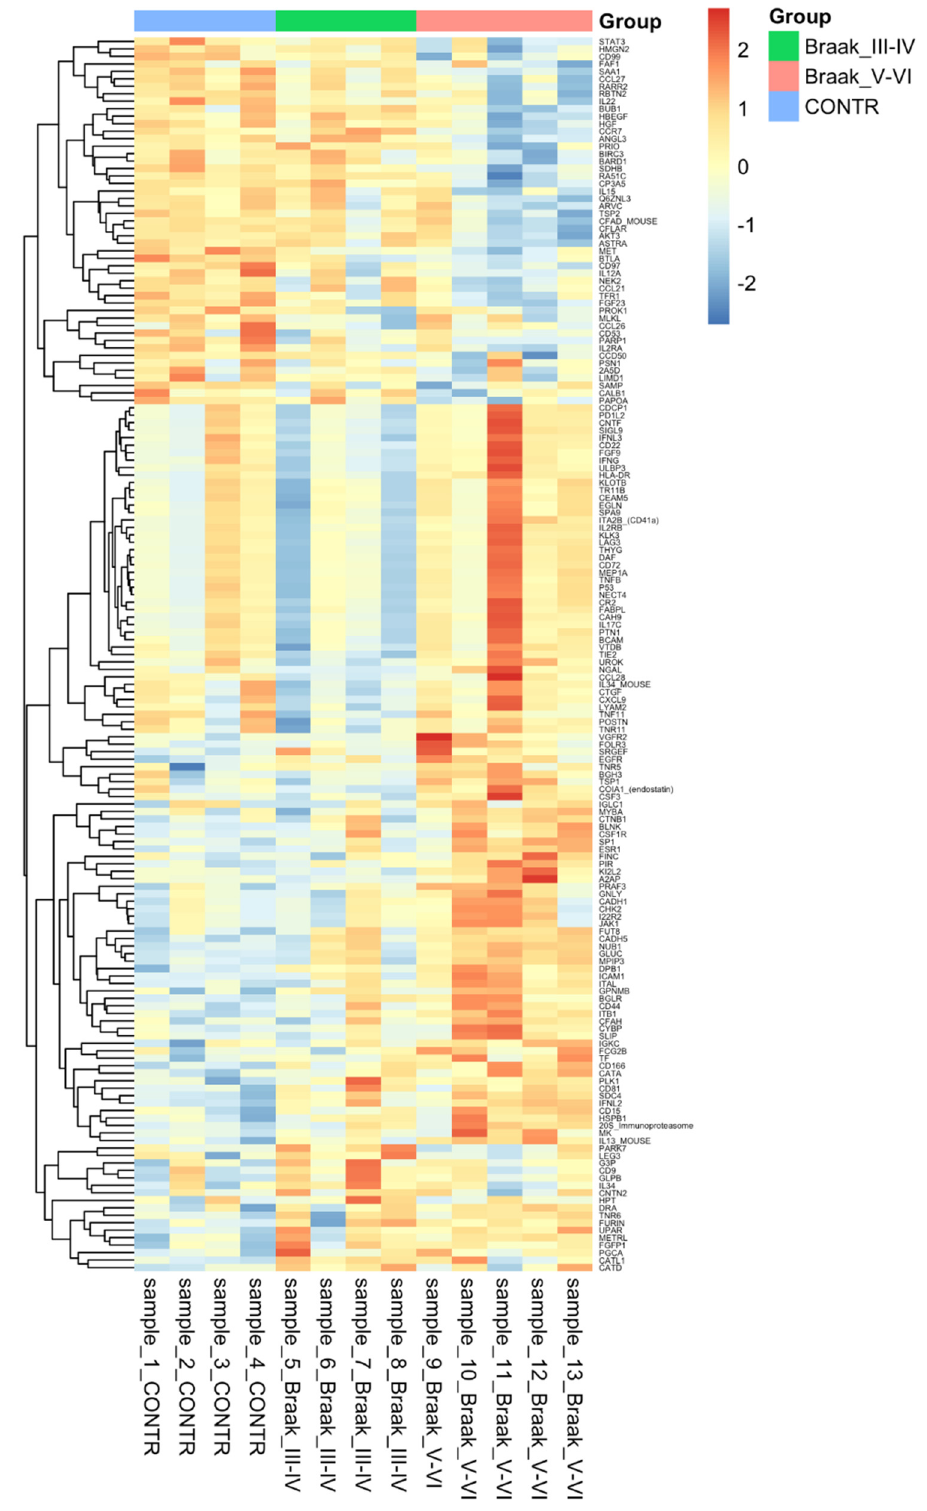
Figure 2. Heatmap showing the expression of 174 differentially regulated proteins in Alzheimer’s disease across the 2 compariosns Control vs. Braak stage IiI–IV and Control vs. Braak stage V-VI. A p -value of less than 0.05 was considered significant. Hierarchal clustering is present on the left with colours relevant to their group. This was made using heatmap.2 in the R programming language with complete linkage, and Euclidean distance used to compute.